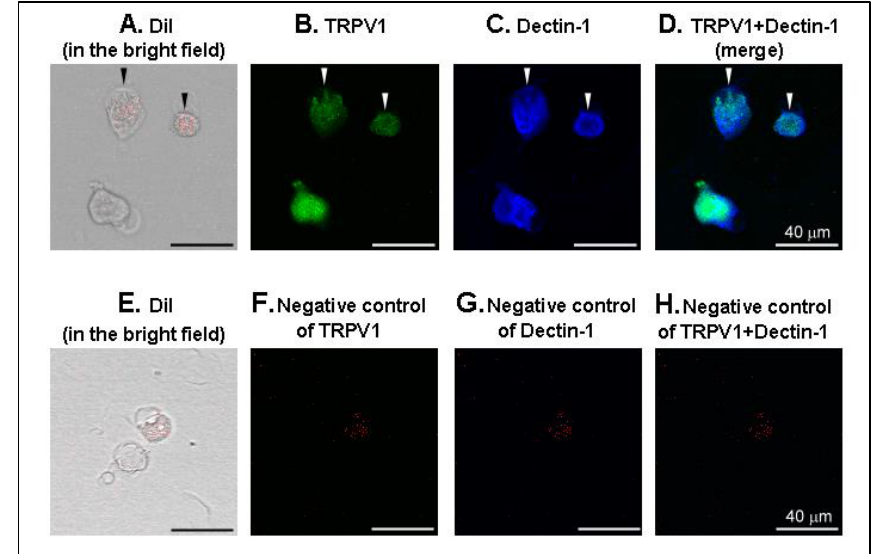
Figure 9. Representative photographs of triple-labeling immunofluorescence of DiI, TRPV1, and Dectin-1 in the lung vagal neurons. ( A , E ): DiI labeling in red in the bright field was served as positive control; ( B ) TRPV1 staining in green; ( C ) Dectin-1 staining in blue; ( D ) the merged image; ( F – H ): negative control of TRPV1, Dectin-1, and TRPV1 + Dectin-1, respectively. We used bovine serum albumin to demonstrate specific binding of primary antibody. Arrowheads are added to depict co-localization of DiI labeling, TRPV1 staining, and Dectin-1 staining in the same neurons. Scale bar, 40 μm.